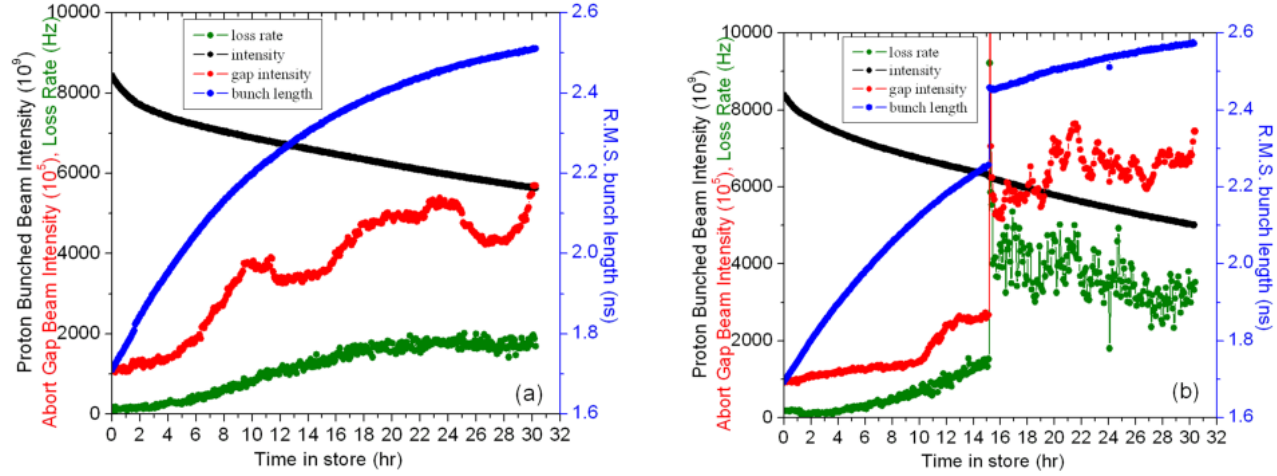
FIG. 7. (Color) (a) Left—decay of proton bunch intensity (black curve) and growth of its length (blue) as well as abort gap loss rate at CDF detector (green) and proton abort gap intensity (red) in a typical HEP store (#5157) when the TEL was on; (b) right—same for store #5136, in which one of 4 proton rf stations tripped off in the middle of the